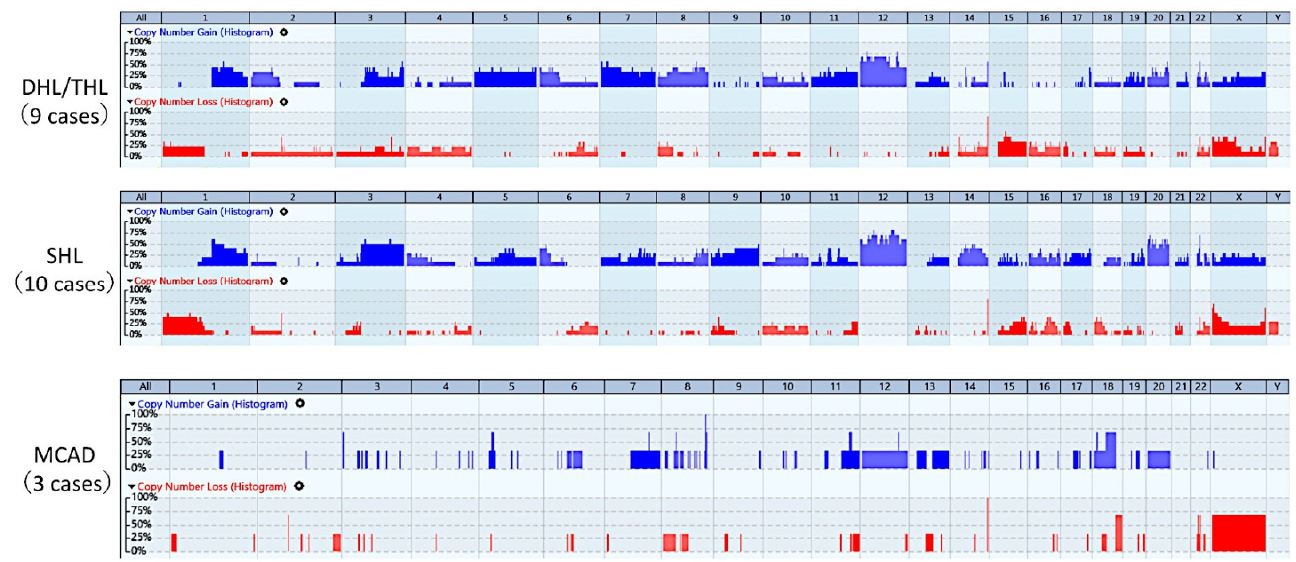
Figure 1. Copy number alterations of diffuse large B-cell lymphoma with abnormal MYC status. Copy number alteration profiles are similar between DHL/THL and SHL and both subtypes share the same regions of gains (blue histogram) and losses (red histogram). Gains in chromosomes 9 and 16 are more frequent in SHL. DHL/THL have larger areas with losses at chromosomes 2 to 4, although at a low frequency. Copy number alterations in MCAD are fewer than those in DHL/THL and SHL. The gain at 8q24 reflected the FISH results.